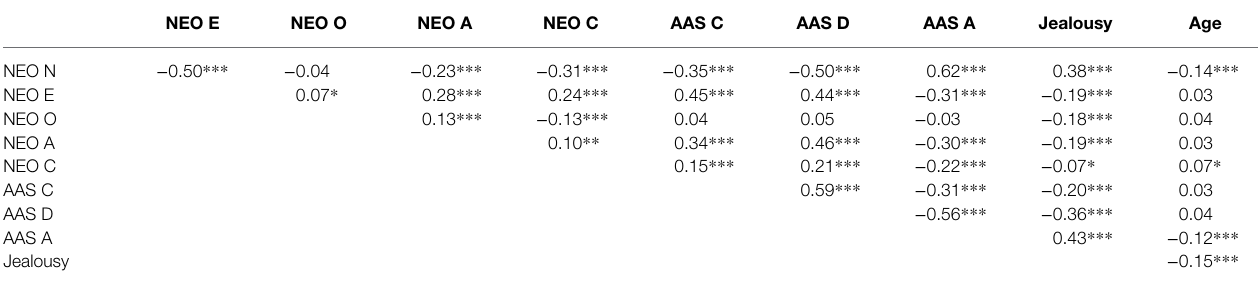
TABLE 3 | Pearson correlations between jealousy, the Big Five personality traits, the adult attachment dimensions close , depend, and anxiety, romantic jealousy, and age in 847 participants. NEO E